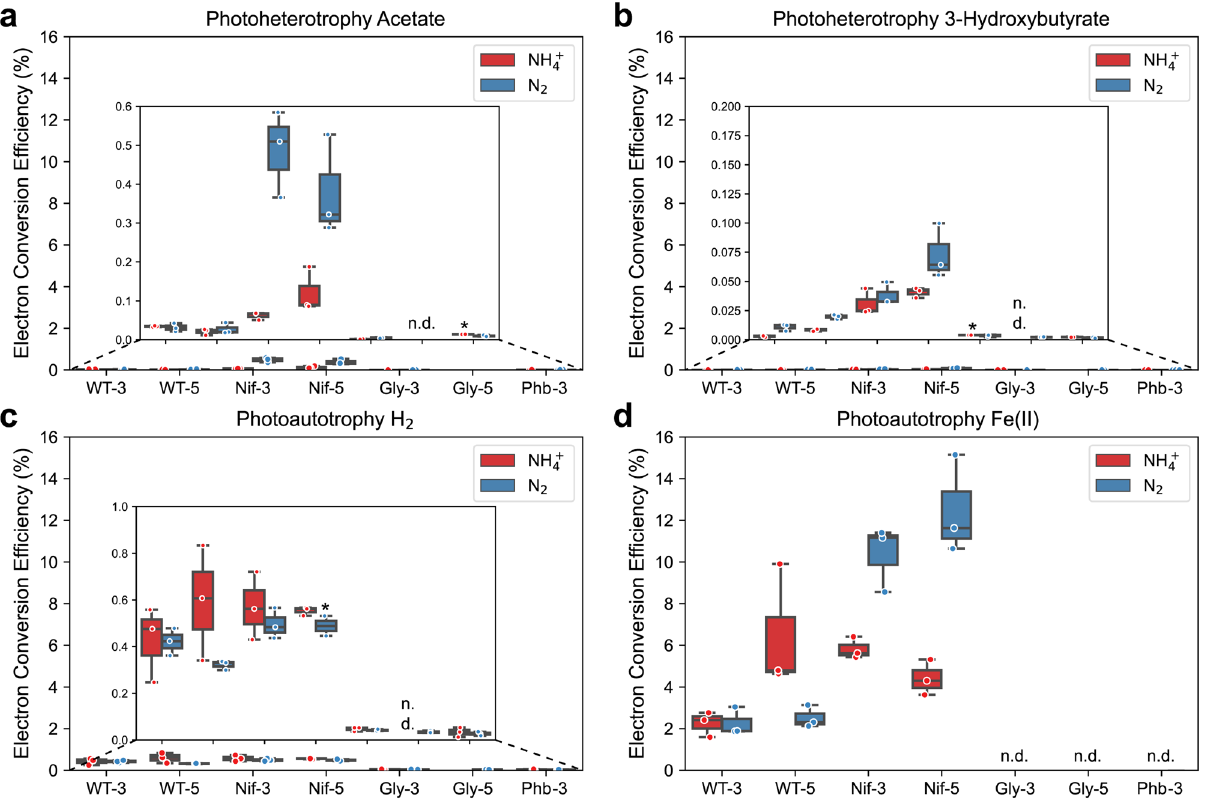
Fig. 6 The nitrogenase double mutant (Nif) converts electrons to n -butanol more ef fi ciently. The electron conversion ef fi ciency towards n -butanol (%) when TIE-1 was cultured with ammonium (NH 4 + , red) or dinitrogen gas (N 2 , blue) and a acetate (photoheterotrophy) b (3-hydroxybutyrate (photoheterotrophy) c hydrogen (H 2 ) (photoautotrophy); and d ferrous iron [Fe(II)] (photoautotrophy). CO 2 was present in all conditions. Data are from n = 3 of independent experiments. Boxes that only have two biological replicates are indicated by ‘ * ’ . WT-3: wild type with 3-gene cassette; WT-5: wild type with 5-gene cassette; Nif-3: nitrogenase knockout t with 3-gene cassette; Nif-5: nitrogenase knockout with 5-gene cassette; Gly-3: glycogen synthase knockout with 3-gene cassette; Gly-5: glycogen synthase knockout with 5-gene cassette; Phb-3: hydroxybutyrate polymerase knockout with 3-gene cassette, n.d.